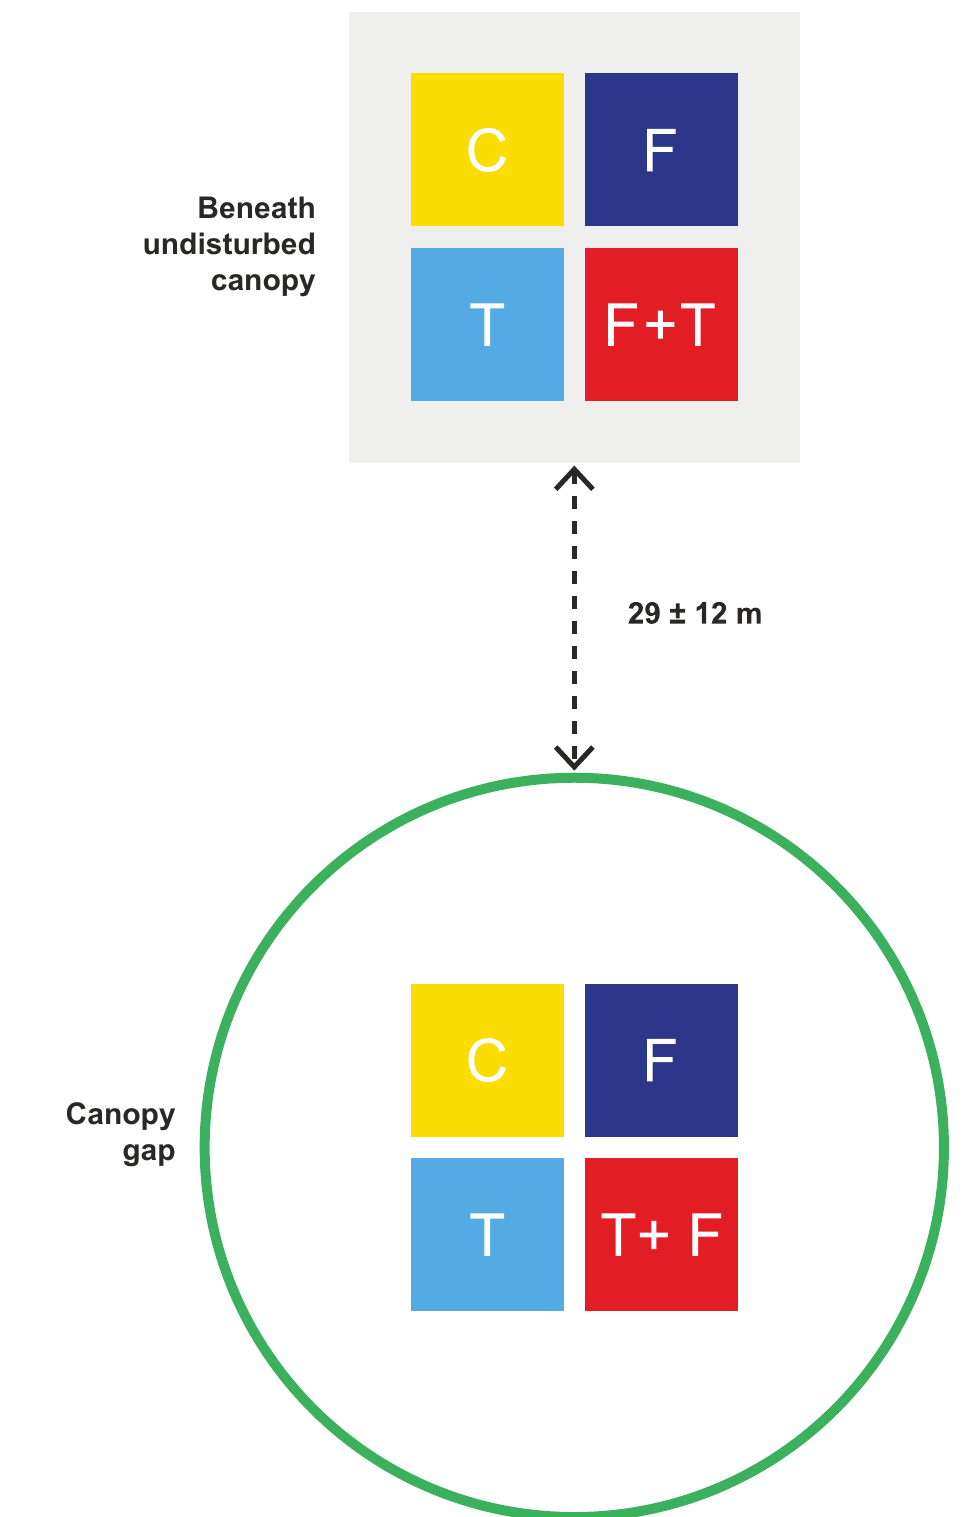
Fig 1. Factorial design of the experiment undertaken on seedlings of two co-occurring species under two canopy conditions. The canopy gap is outlined by a green circle and beneathundisturbedcanopy as a shaded area.